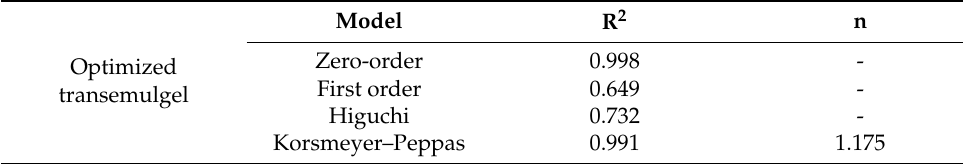
Table 6. Drug release